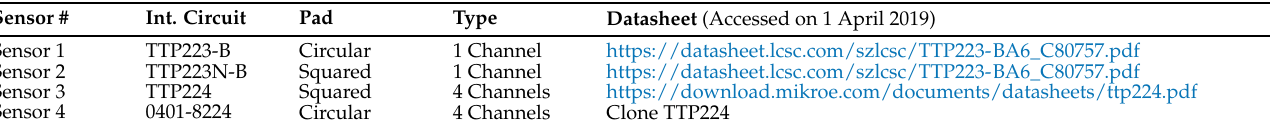
Table 7. Electrical characteristics of the tested